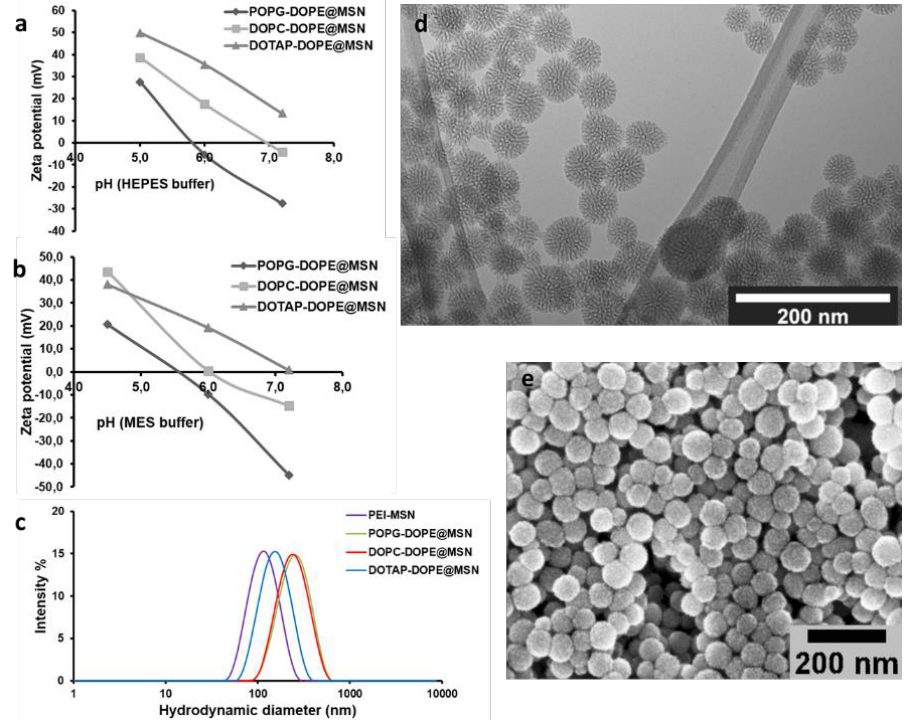
Figure 1. Characterization of mesoporous silica nanoparticles (MSNs). ( a ) Zeta potential values in HEPES buffer and ( b ) MES (4-Morpholineethanesulfonic acid) buffer solutions at different pHs; ( c ) dynamic light scattering (DLS) curves of the MSNs under study; ( d ) TEM and ( e ) SEM images of the unmodified MSNs.